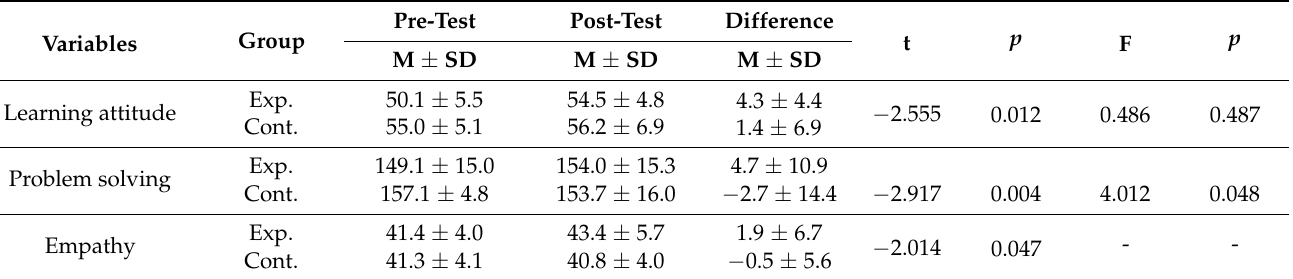
Table 2. Effect of the programs between the two